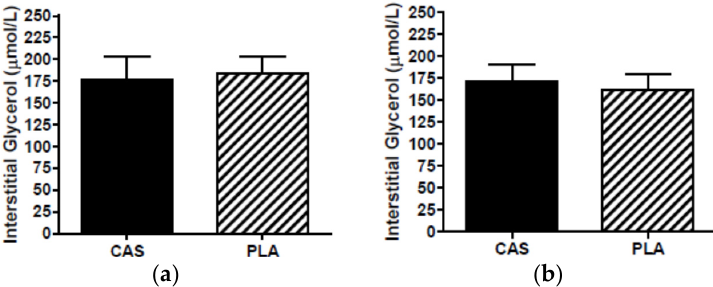
Figure 2. Interstitial glycerol ( a ) overnight during sleep and ( b ) the morning after consumption